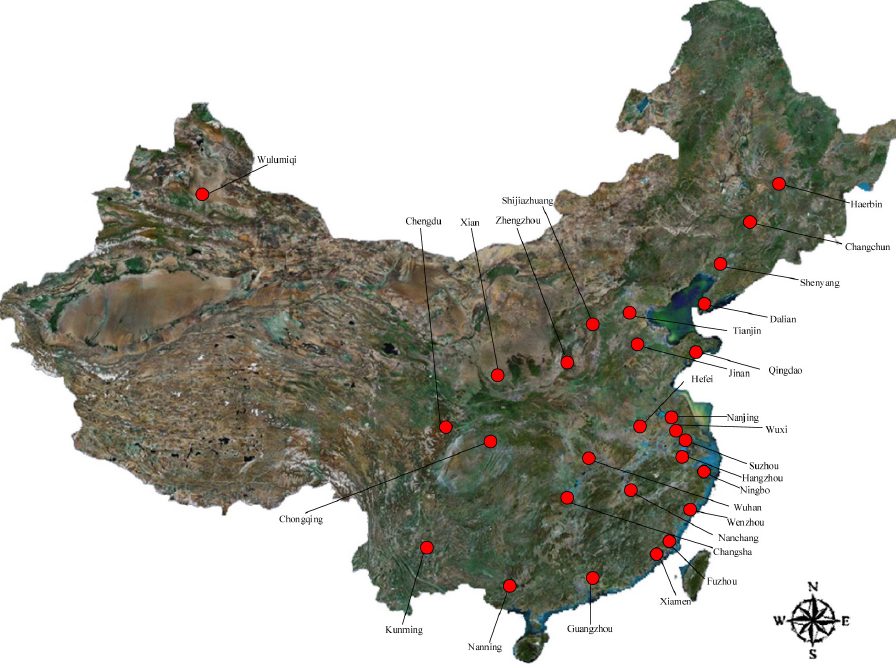
Fig. 3. China’s regional financial center